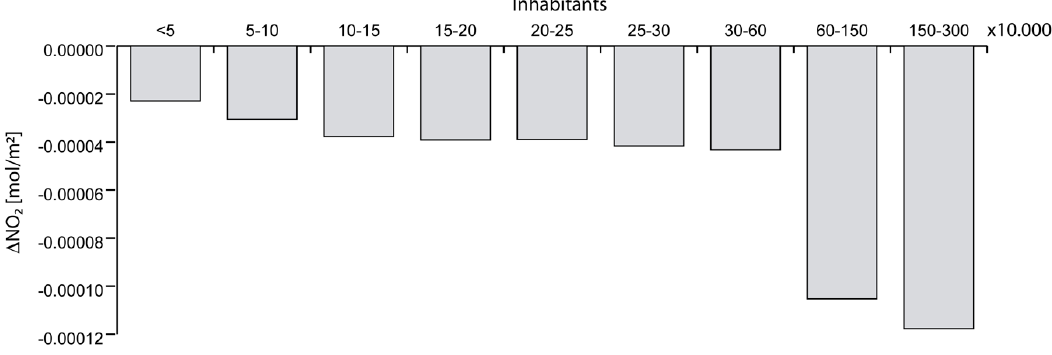
Figure 8. Number of inhabitants versus variation of tropospheric vertical column of NO 2 .